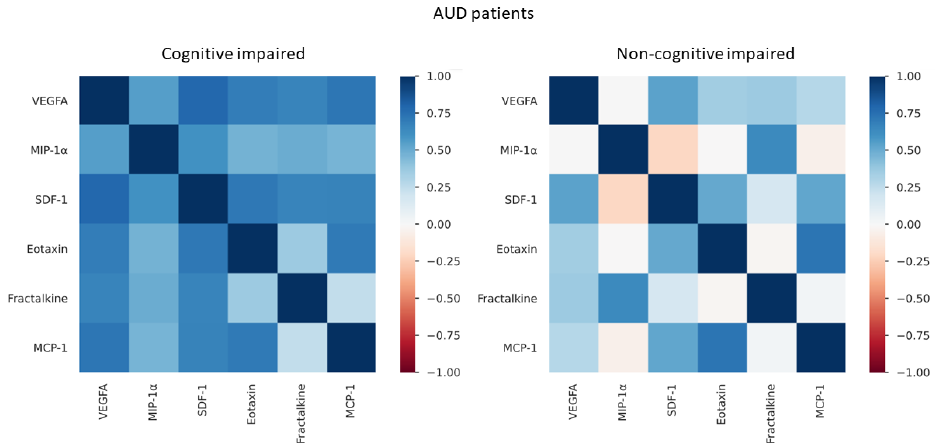
Figure 4. Correlations analysis between VEGFA and chemokines in AUD patients with and without frontal cognitive impairment ( n = 51). Colors show Spearman’s rho correlation coefficient.